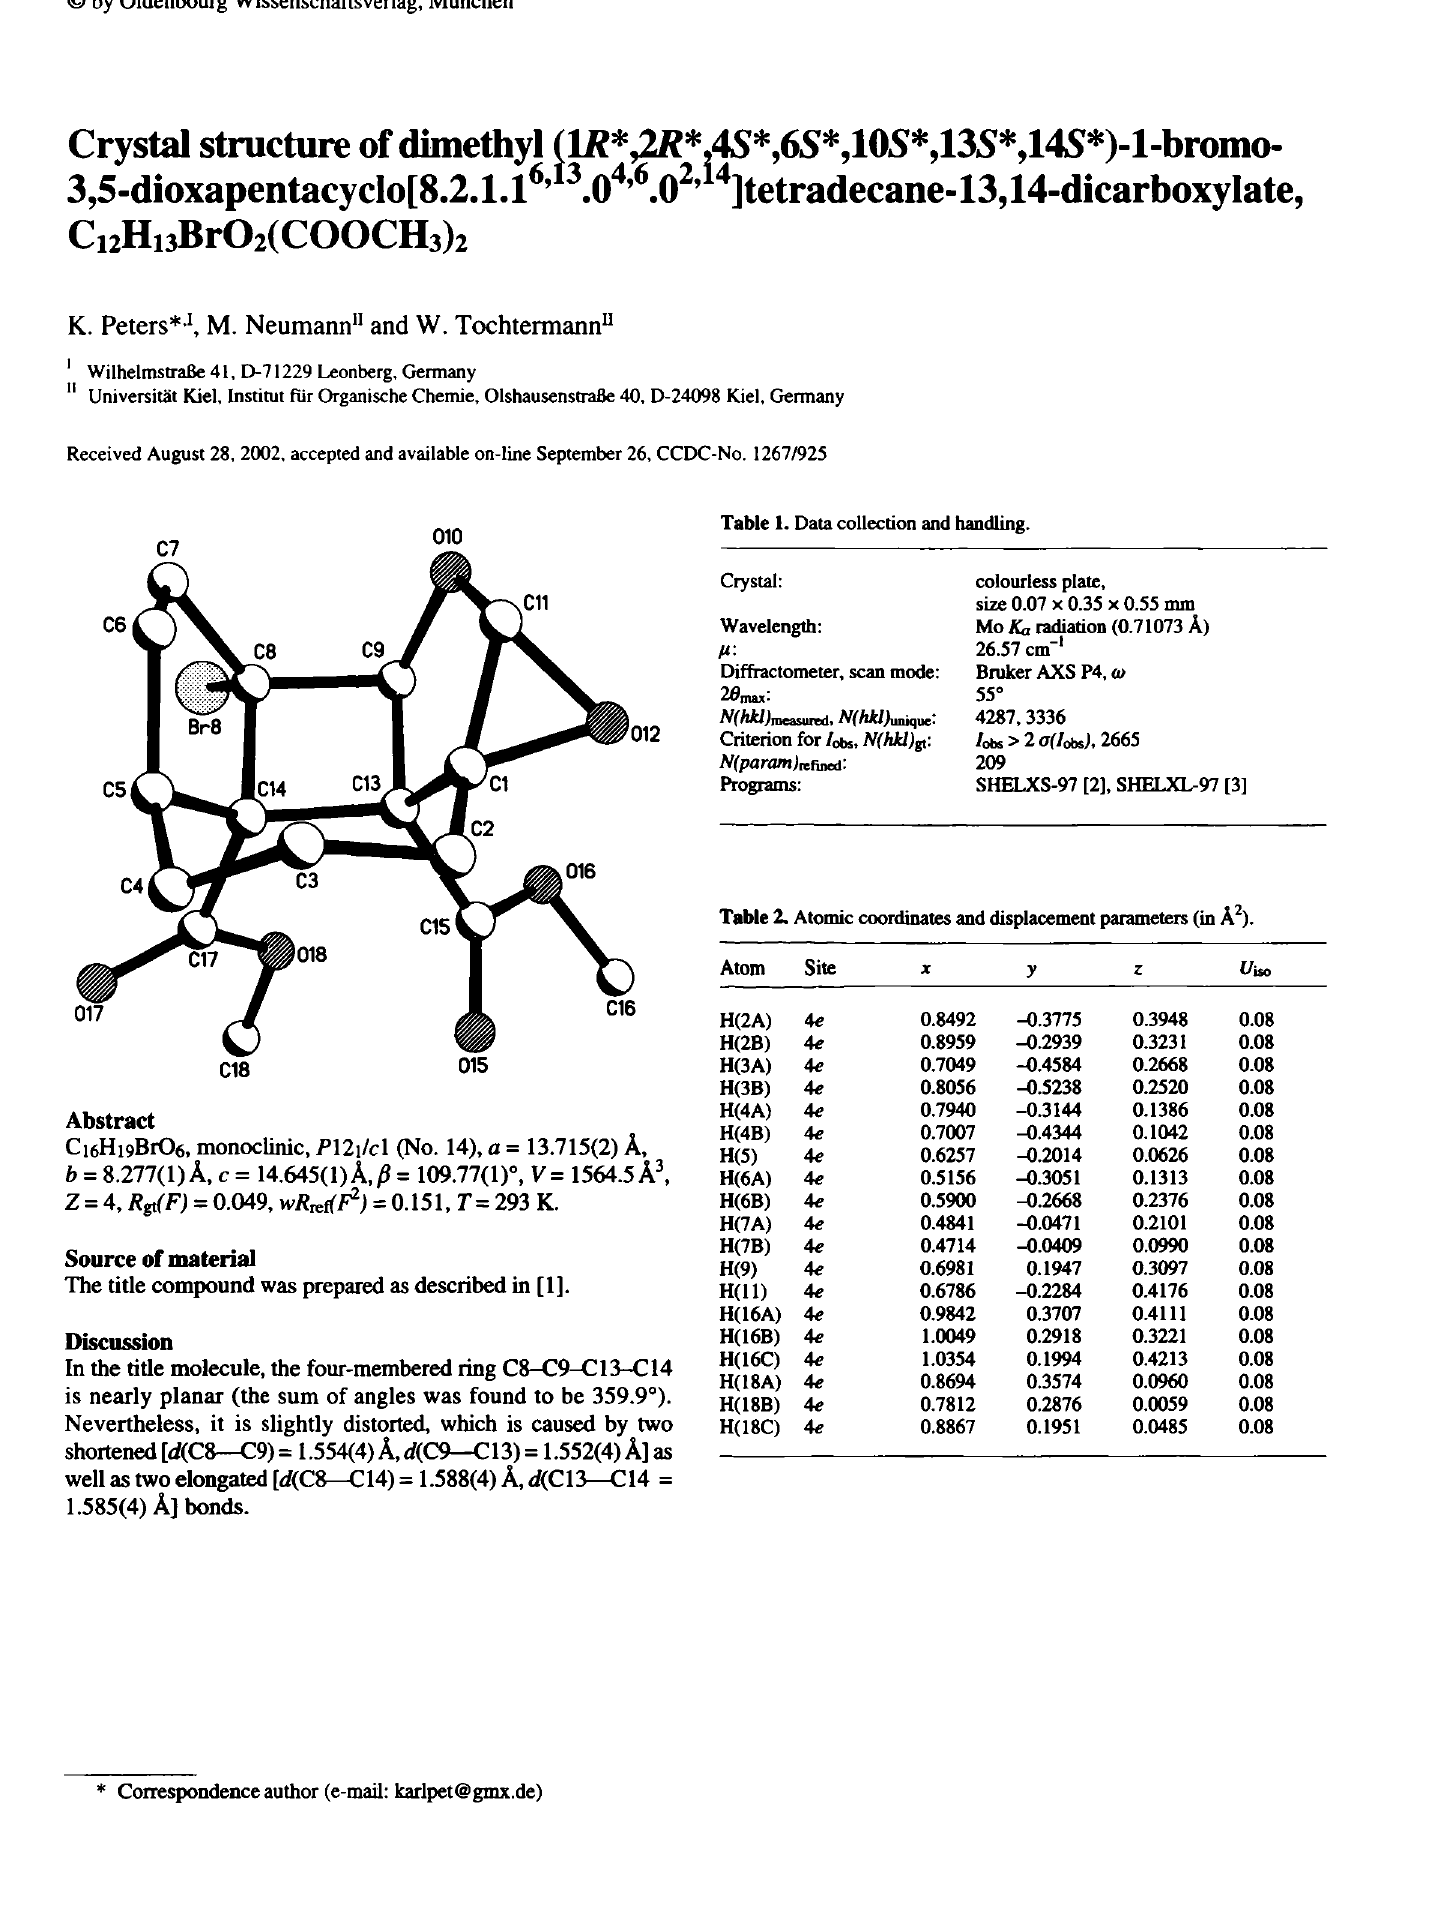
Table 1. Data collection and handling.